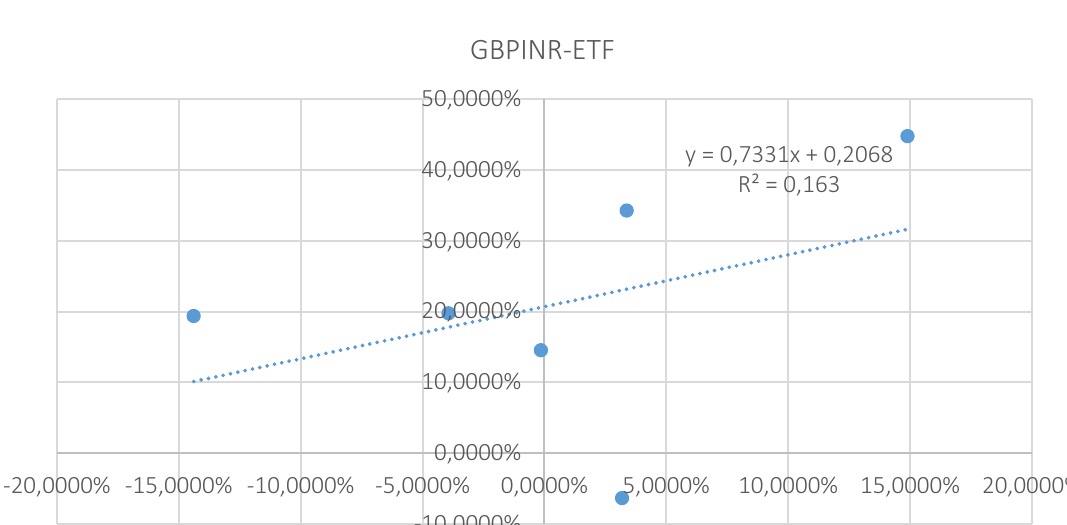
Figure 9. Regression line of USD and